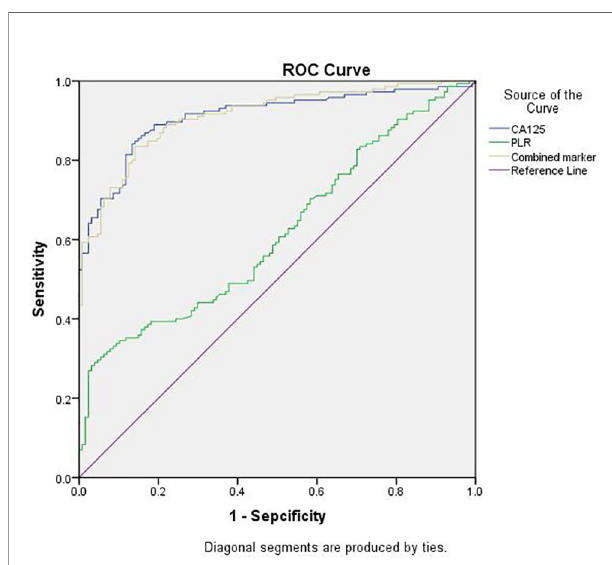
FIGURE 1 | ROC curves of CA125, PLR, and the combined marker for discriminating between EMs group and Cyst group. EMs group, endometriosis group; Cyst group, non-endometriosis group; PLR, platelet-to-lymphocyte ratio; Combined marker, the CA125 level multiplied by the PLR; ROC, receiver- operating characteristic.